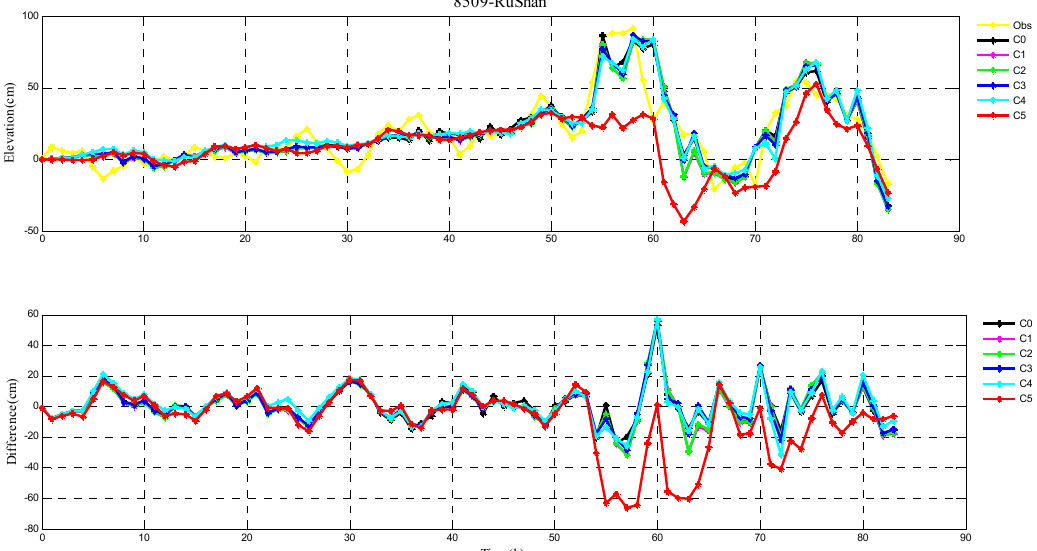
Figure 5. The storm surge elevations (cm) in six cases (C0, C1, C2, C3, C4, C5) and observations (yellow line) (top) and the differences between them (bottom) during Typhoon 7203 at RuShan tide station.